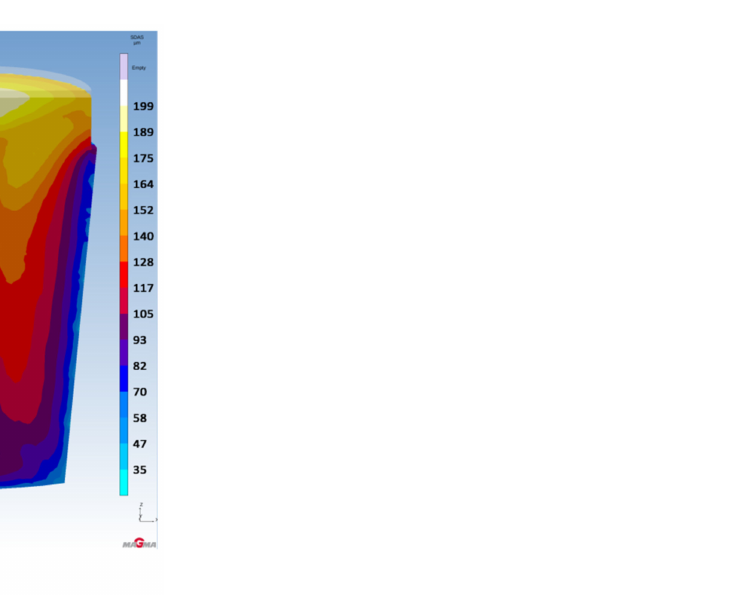
Figure 5. Element segregation, PDAS and secondary dendrite arm spacing (SDAS): ( a ) [wt.% C]; ( b ) [wt.% Si]; ( c ) [wt.% Cr]; ( d ) [wt.% Ni]; ( e ) [wt.% Mo]; ( f ) PDAS; ( g ) SDAS. Element Segregation, PDAS and SDAS in ATABOR Steel Ingot The segregation prediction of ATABOR steel ingot indicates that the concentration of carbon (Figure 7a) varies from 0.006 to 0.020 wt.% assuming the melt analysis value 0.014 wt.%, the concentration of silicon (Figure 7b) varies from 0.33 to 0.57 wt.% assuming the melt analysis value 0.46 wt.%, the concentration of chromium (Figure 7c) varies from 18.22 to 20.05 wt.% assuming the melt analysis value 19.00 wt.%, the concentration of nickel (Figure 7d) varies from 11.95 to 13.63 wt.% assuming the melt analysis value 12.80 wt.%, and the concentration of molybdenum (Figure 7e) varies from 0.77 to 1.08 wt.% assuming the melt analysis value 0.93 wt.%. Figure 7f shows the prediction of primary dendrite arm spacing (PDAS) varying from 193.1 to 557.8 µ m. Figure 7g shows the prediction of